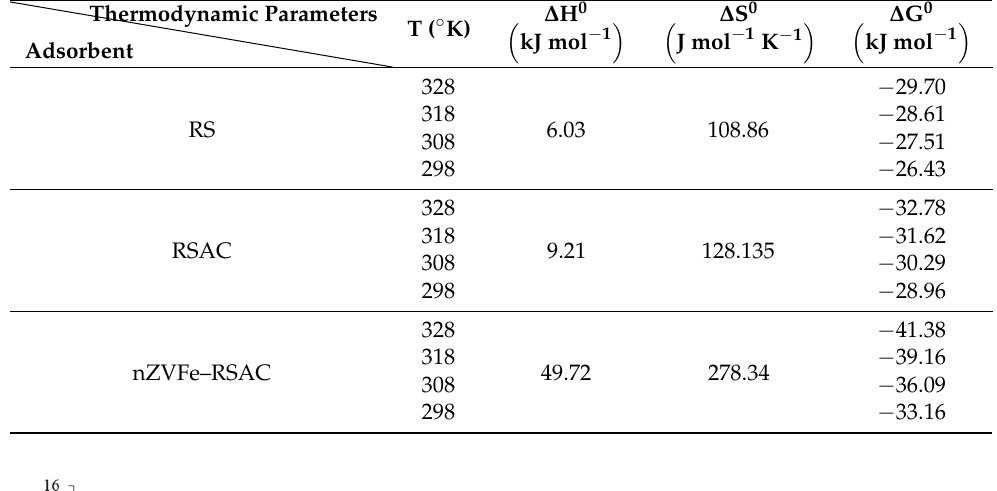
Figure 11. Effect of temperature on the adsorption of Pb(II) onto RS, RSAC, and nZVFe–RSAC (at 25, 35, 45, and 50 °C) (C 0 = 200 mg L (cid:2879)(cid:2869) ). Table 6. Thermodynamics parameters for the adsorption of Pb(II) on nZVFe–RSAC nanocomposite. AdsorbentThermodynamic Parameters